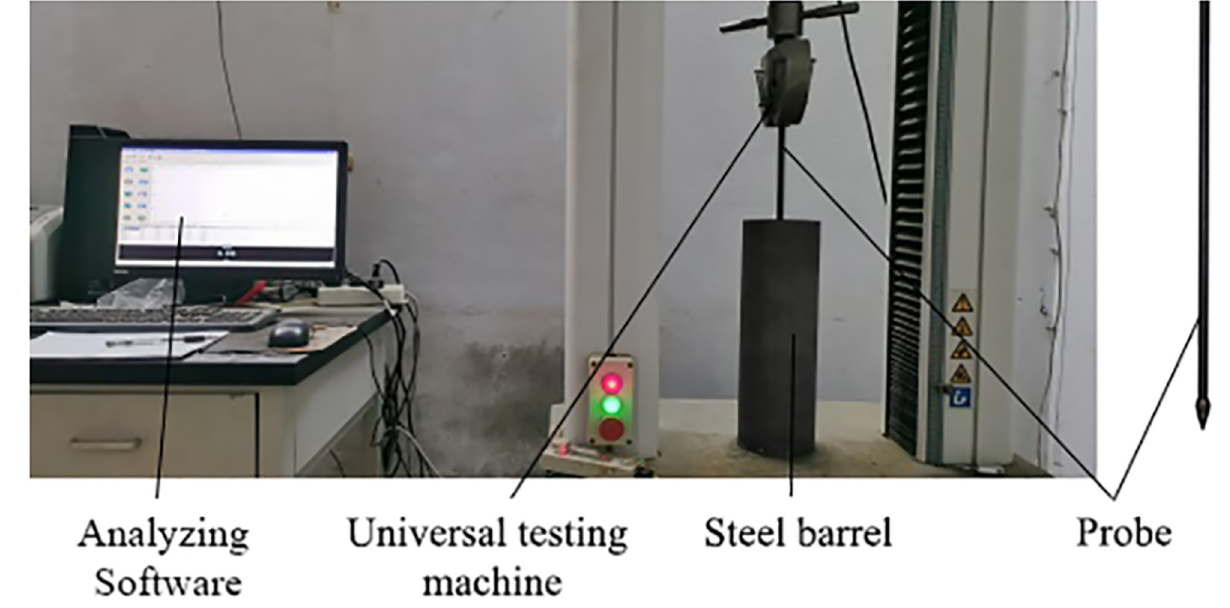
Fig 3. Indoor test of probe penetration into